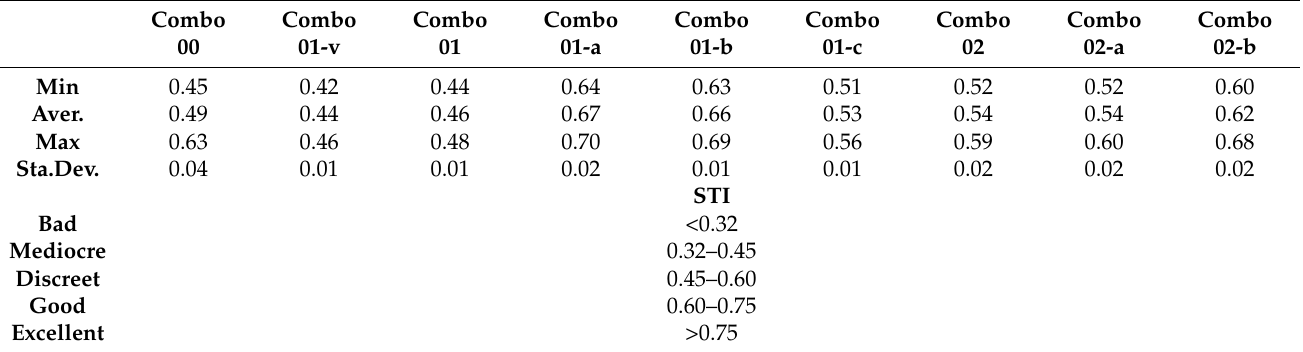
Table 16. Speech Transmission Index